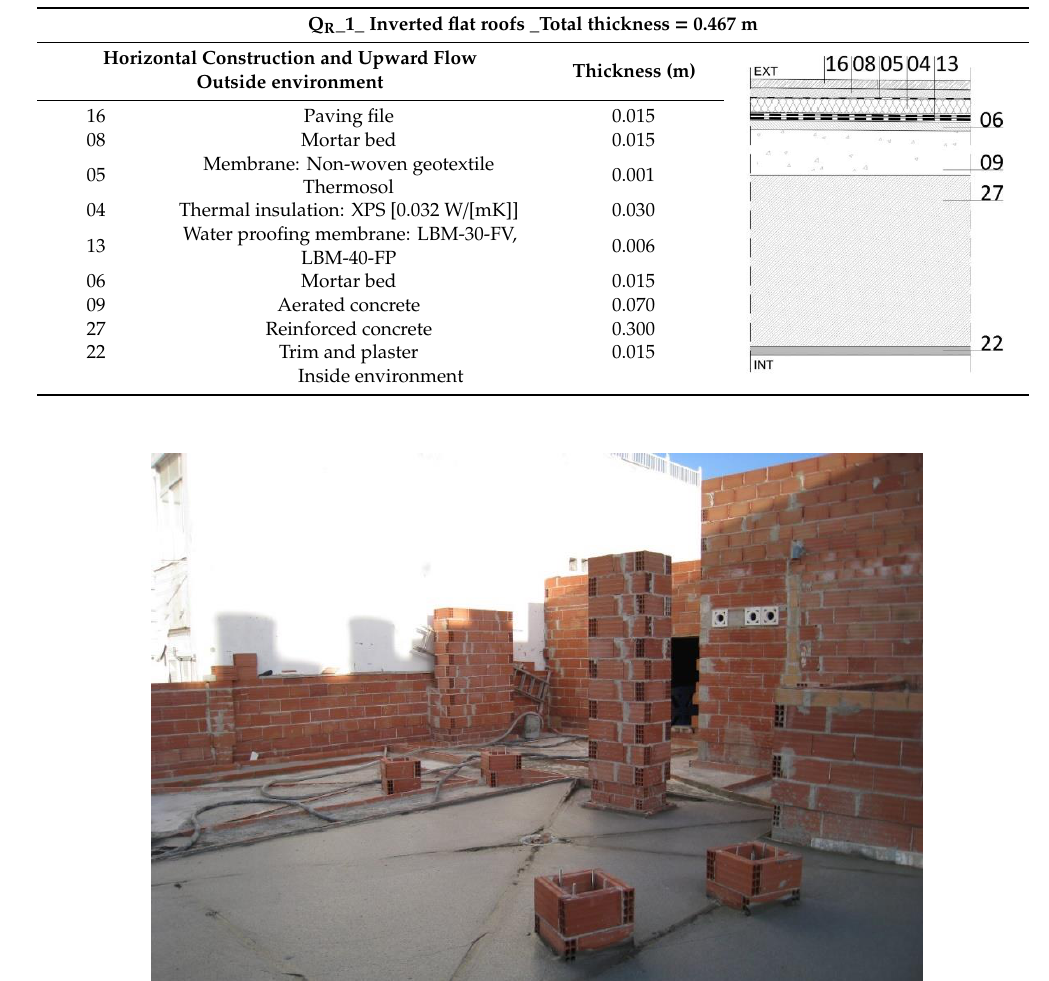
Figure 1. Image of the main façade of the housing block and floor plan.